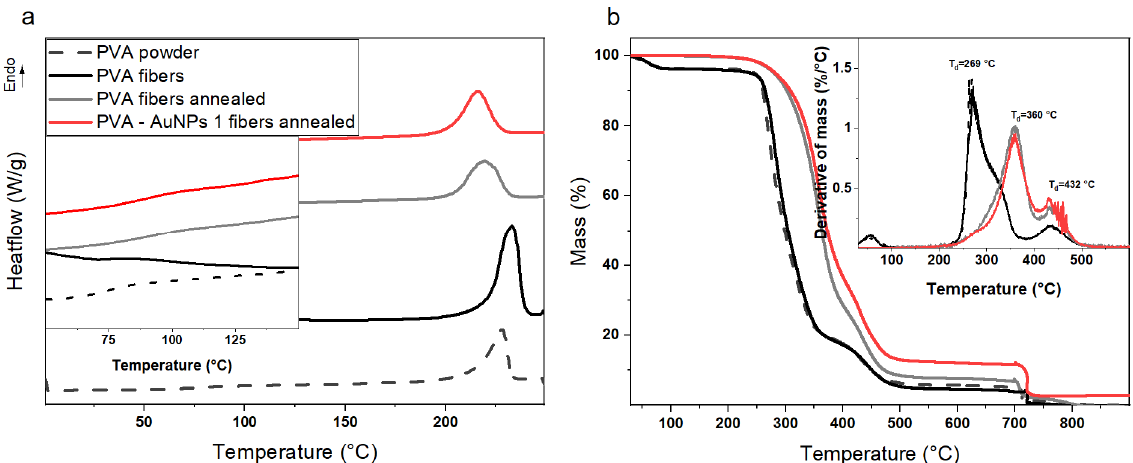
Figure 5. ( a ) DSC and ( b ) TGA thermograms of PVA powder, as-prepared PVA fibers, annealed PVA fibers, and annealed PVA-AuNPs 1 fibers. The inset in panel ( a ) reports a portion of the DSC curves to highlight the sample glass transition temperature, whereas the inset in panel ( b ) represents derivative thermogravimetric analysis (DTGA) curves. Table 2. Thermal properties and crystallinity degree of PVA powder, as-prepared PVA fibers, annealed PVA fibers, and annealed PVA-AuNPs 1 fibers. Sample